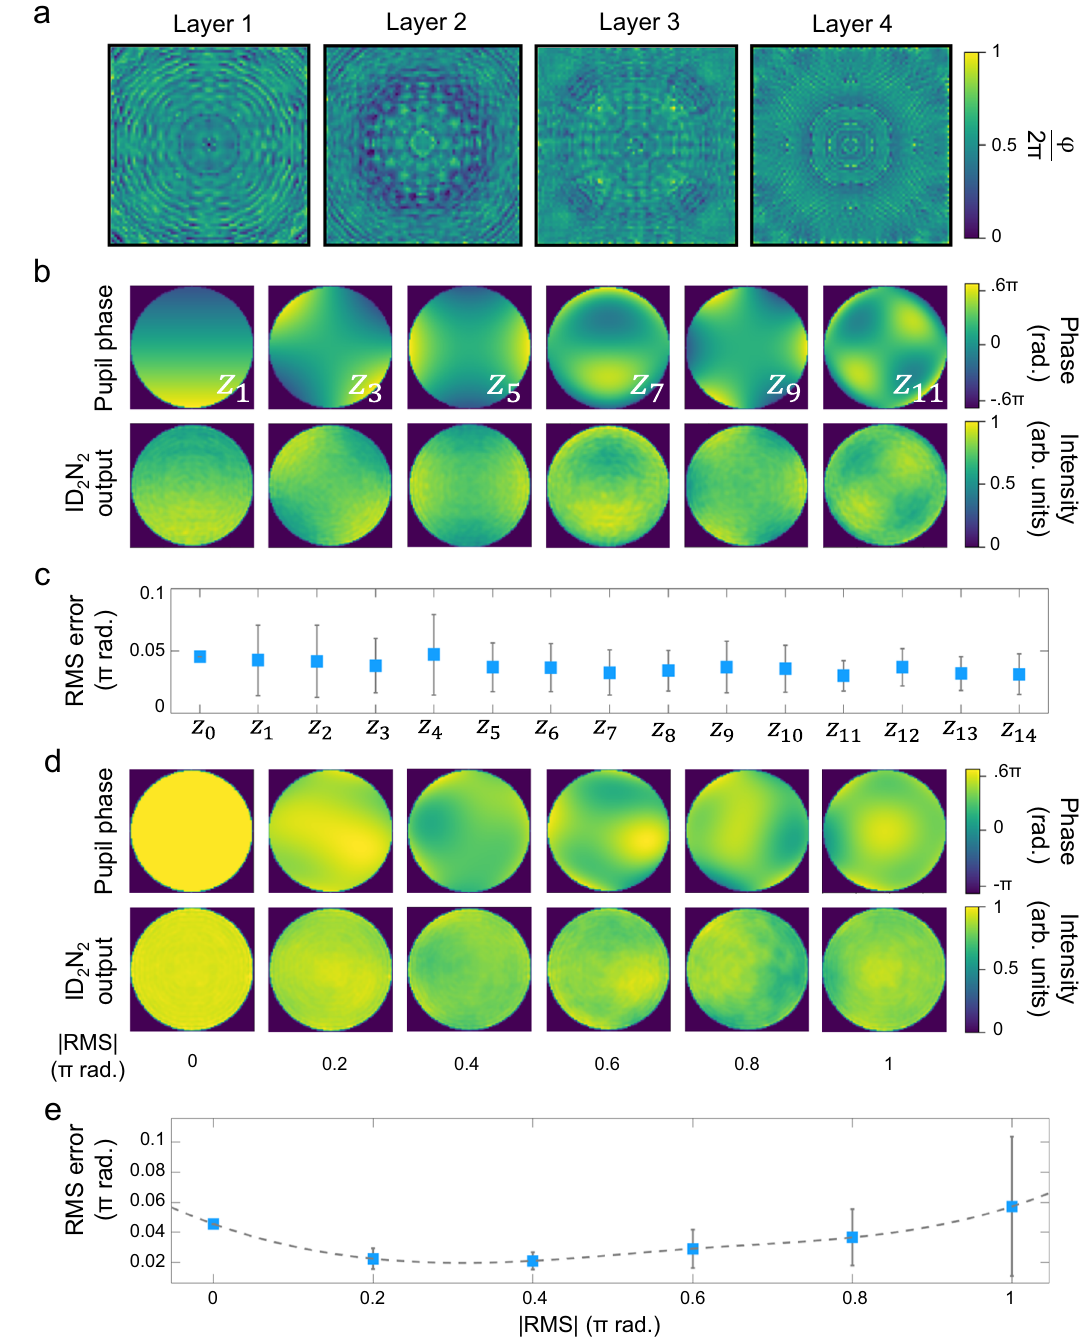
Fig. 3 | ID 2 N 2 response to single and combined Zernike pupil phase testing. a Phase matrices of the trained four-layer DN 2 . b Pupil phase and simulation results of ID 2 N 2 output for six Zernike polynomials. The complete results and performance analysis for the fi rst 14 Zernike polynomials are reported in Sup- plementary Fig. 3 and Supplementary Fig. 4. c Comparison of the root mean square (RMS) error between the original pupil phase and the ID 2 N 2 output for